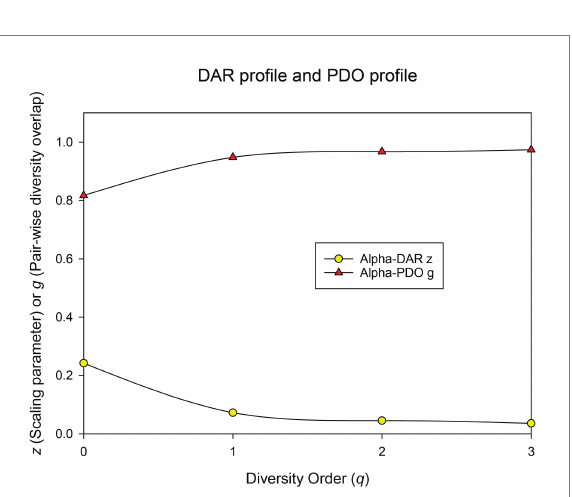
FIGURE 3 The DAR profile ( z-q ) and PDO profile ( g-q ) of the human breast milk microbiome in healthy